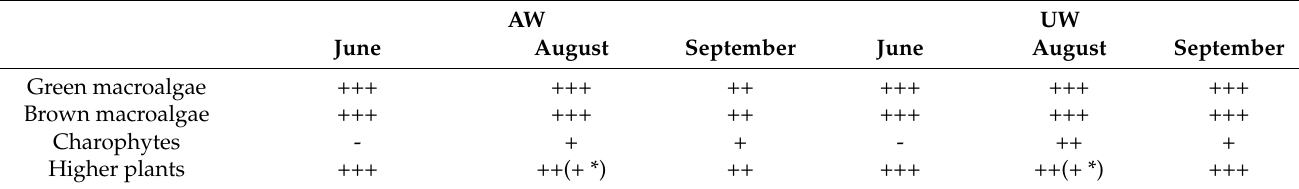
Table 1. Coincident production and reflectance measurements for AW (above water surface) and UW (underwater) datasets. Coincident measurements available for three days (+++), two days (++), or one day (+) for the vegetation period in June, August, and September. No coincident data (-) available for the